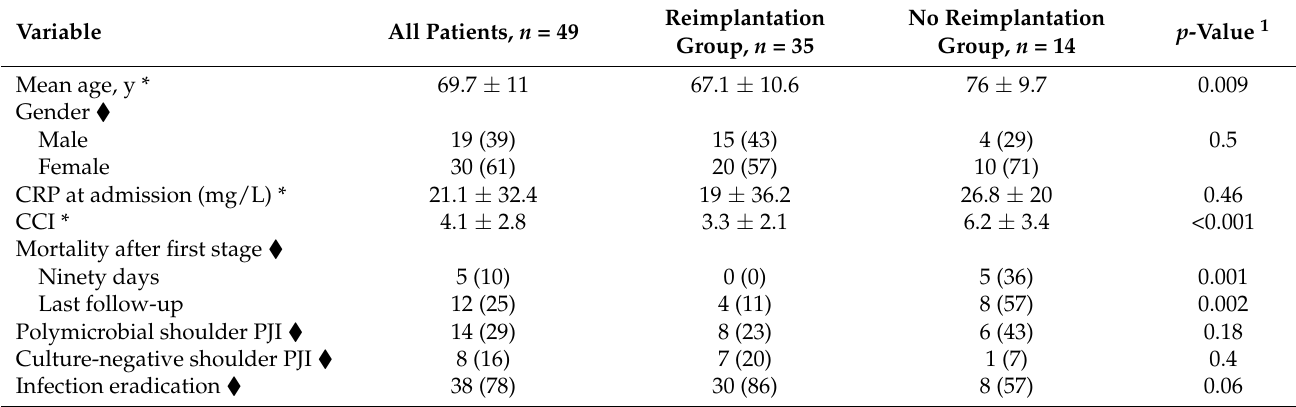
Table 1. Demographic data, clinical, and laboratory findings of the study cohort and groups with and without subsequent